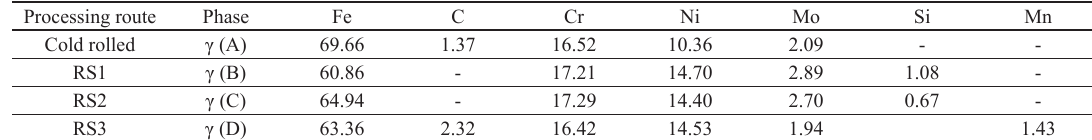
Table 2. Semi-quantitative EDS analyses in the 316L stainless steel after cold rolling and rapid solidification (wt.%). Processing